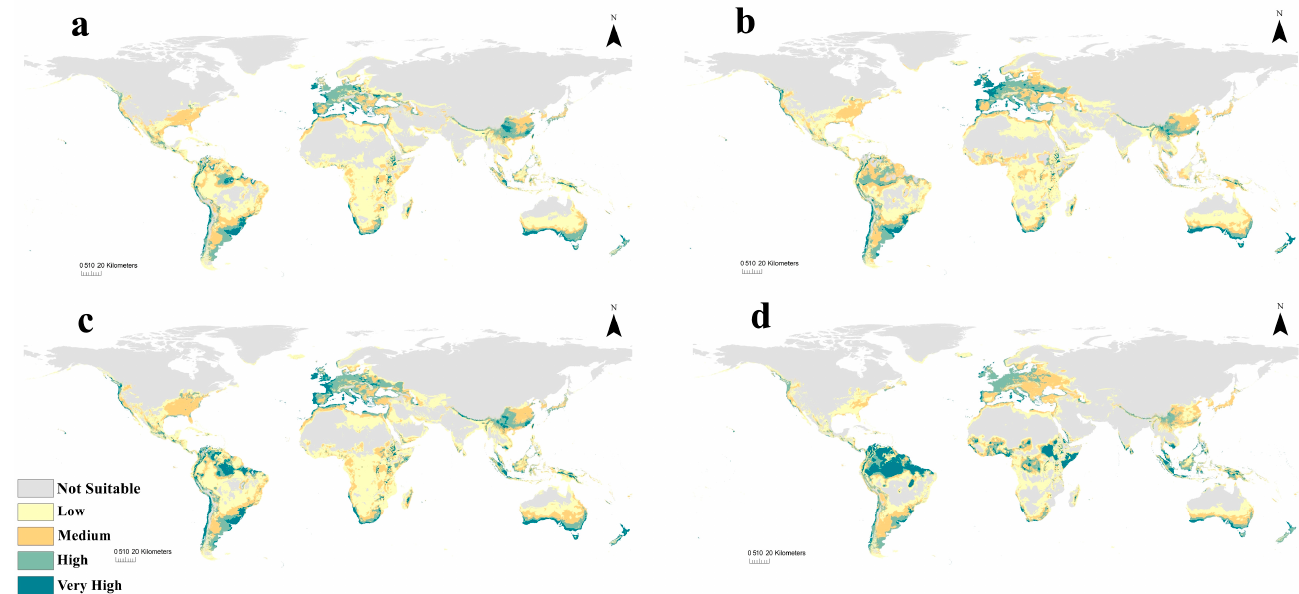
Figure 4. Maxent models of predicted global future distribution of C. albiceps under two RCPs: ( a ) 2050 for RCP 2.6; ( b ) 2050 for RCP 8.5; ( c ) 2070 for RCP 2.6, and ( d ) 2070 for RCP